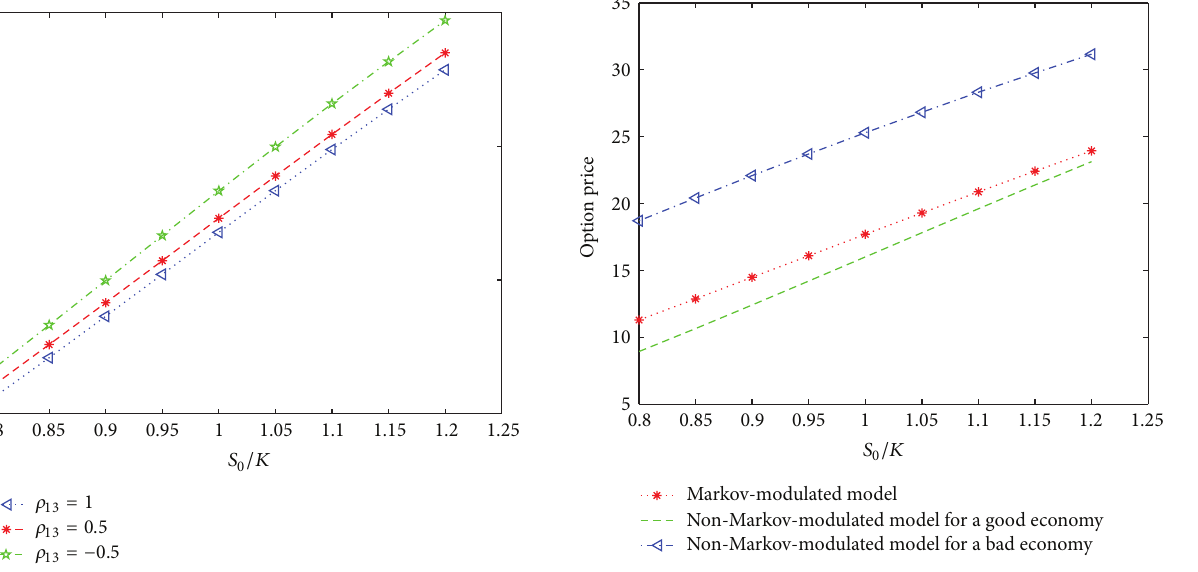
Figure 4: The option price with different correlation coefficients 𝜌 13 for 𝑇 = 1 , 𝜔 = 0.4 , 𝜌 12 = 0.7 , and 𝜌 23 = 0.6 .